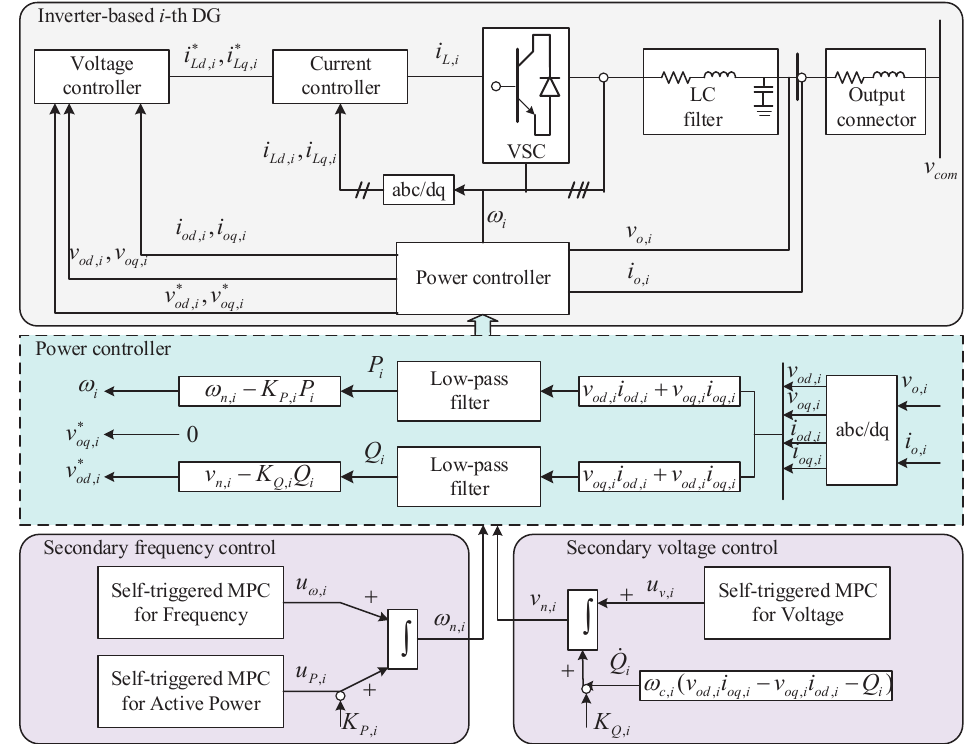
Figure 2. The framework of the inverter-based secondary control using the self-triggered